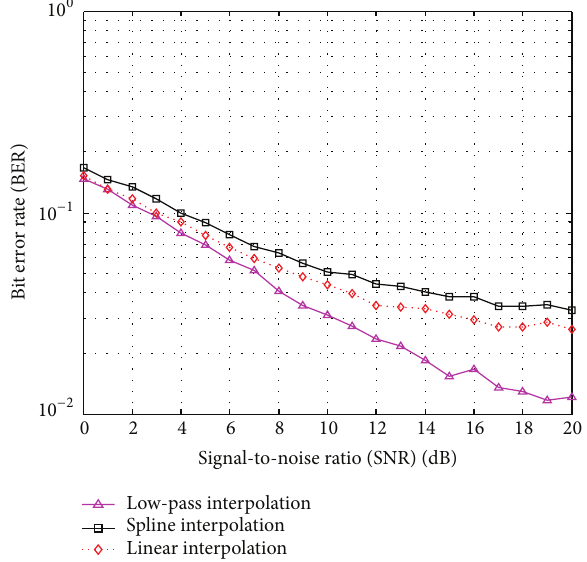
Figure 9: BER performance versus SNR for the FBMC/OQAM system with the various interpolation methods. 𝑀 = 2048 , 𝑁 𝑝 = 𝑇 = 0.0167 256 , and 𝑓 𝑑 𝑠